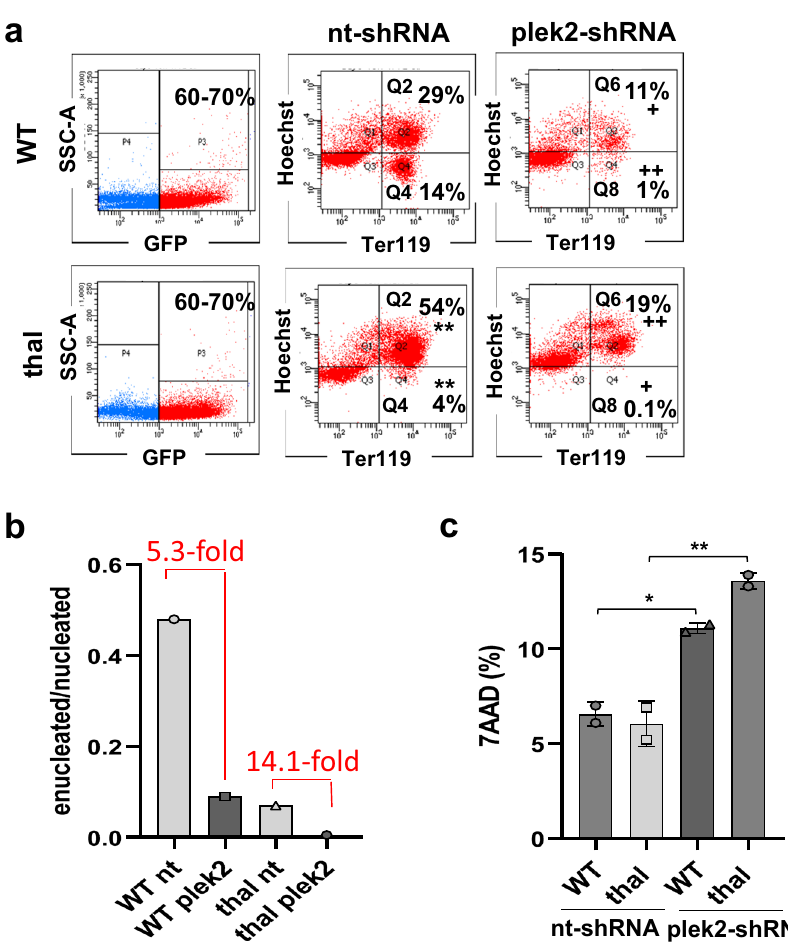
Fig. 3 Pleckstrin-2 knockdown in vitro induces cell death and decreases enucleation particularly in fetal liver cells from β -thalassemic embryos. a Flow cytometry analysis of nucleated (Q2) and enucleated (Q4) cells after nt-shRNA, and nucleated (Q6) and enucleated (Q8) cells after plek2-shRNA transfection in early stage (CFU-E) erythroblasts derived from Ter119-negative fetal liver cells (FLCs) from E13.5 WT and β -thalassemic embryos, revealing the expected higher degree of proliferation and an enucleation defect in β -thalassemic relative to WT nt-shRNA transfected cells; plek2-shRNA transfection result in a decreased fraction of nucleated (Q6) and enucleated (Q8) cells in WT and β -thalassemic cells. b Flow cytometry analysis of ( a ) demonstrates a more severe effect on enucleation in β -thalassemic plek2-shRNA transfected cells compared to WT plek2-shRNA transfected cells. c Flow cytometry analysis of cell death using 7-AAD demonstrates no difference between WT and β -thalassemic nt-shRNA transfected FLCs with signi fi cant increase in cell death in plek2-shRNA transfected WT and especially β -thalassemic FLCs (from ( a )). ( n = 3 mice/group, experiment repeated twice). All data are reported as mean ± s.e.m. and p < 0.05 (one-way ANOVA) was considered statistically signi fi cant. (** p ≤ 0.005 vs. WT nt-shRNA; + p ≤ 0.05